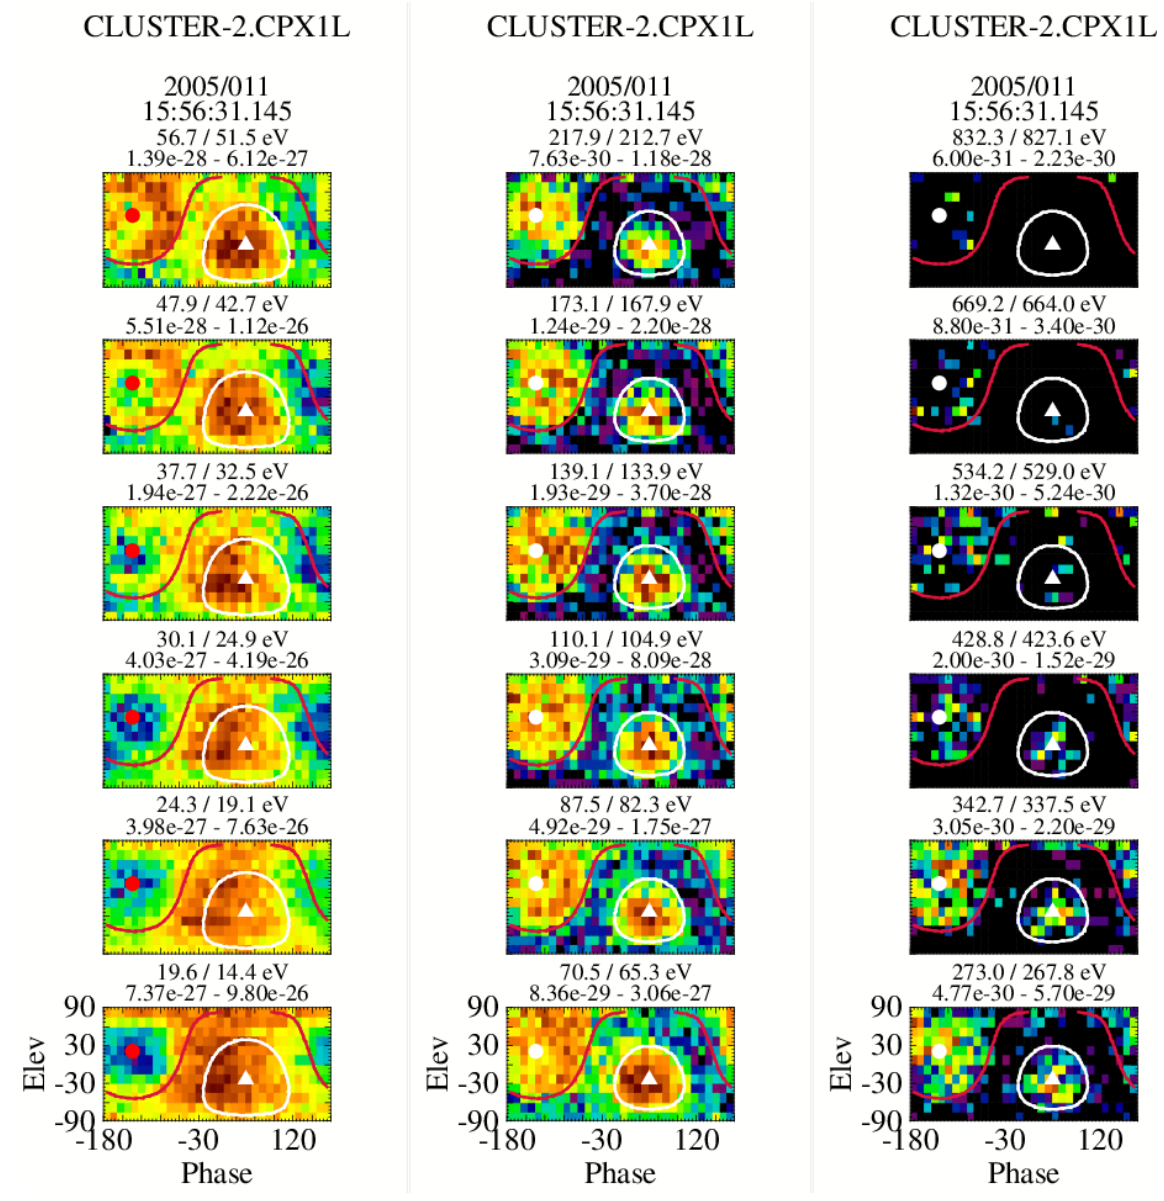
Figure 4. A set of φ – θ plots showing each energy step from 15.8 to 669.2eV from a single eVDF in the foreshock. The white and red traces are lines of constant pitch angles (120 and 75 ◦ ) and are shown solely to indicate the areas where the strahl (white) and return electrons (red) might be expected to be found. The presence of either population may not exist at any given